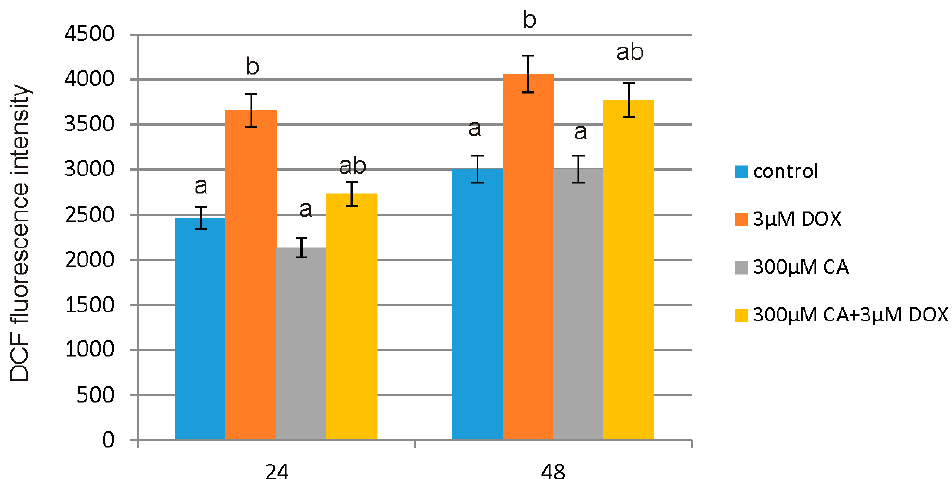
Figure 9. The effect of DOX, CA and CA + DOX on the level of intracellular ROS in fibroblasts. The cells were incubated with 3 µ M DOX, 300 µ M CA and DOX (3 µ M) combined with CA (300 µ M) for 24 h and 48 h Mean values from three independent experiments ± SD are shown. Different letters (a, b) indicate statistical differences ( p ≤ 0.05) between control, 3 µ M DOX, 300 µ M CA and DOX combined with CA estimated by Tukey’s test.